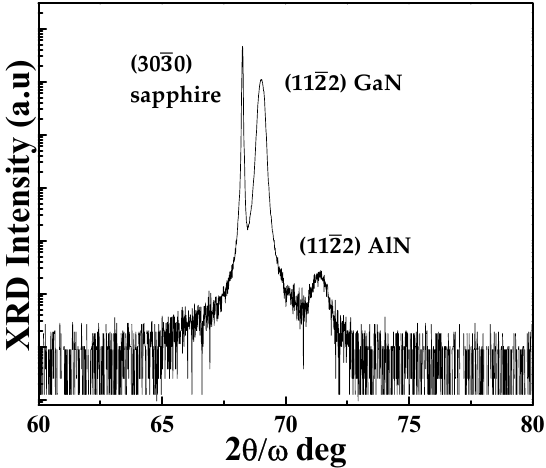
Figure 2. HR-XRD 2θ- ω scans of GaN grown on m -plane sapphire for all samples. Figure 2. HR-XRD 2 θ - ω scans of GaN grown on m -plane sapphire for all